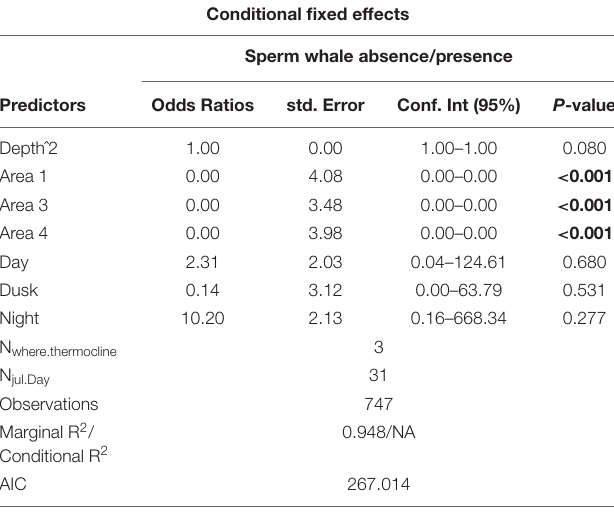
TABLE 4 | Model output for sperm whales.